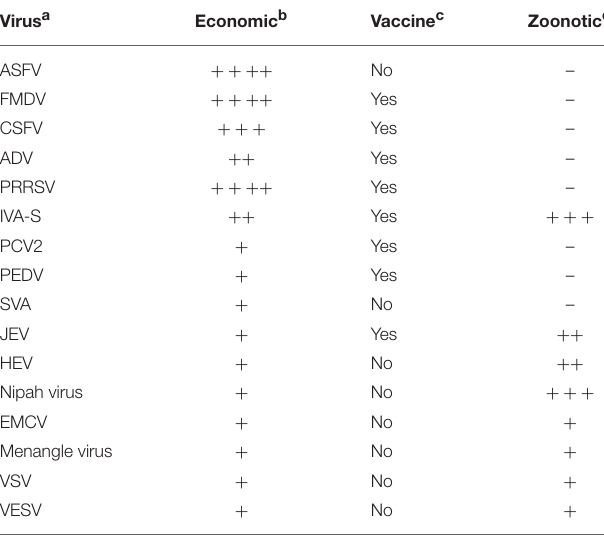
TABLE 1 | Swine viral pathogens of economic or zoonotic